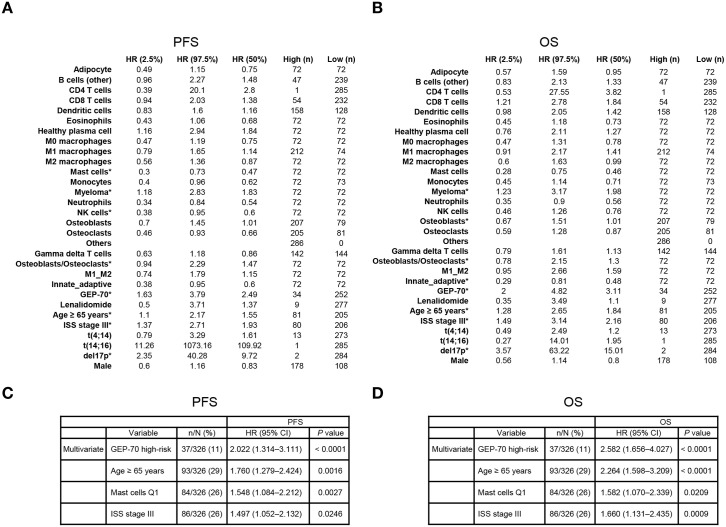
Pretreatment regression models for cell-type, clinical, and cytogenetic characteristics.(A, B) Univariate Cox proportional HRs for PFS and OS (respectively) from 286 pretreatment samples with full cytogenetics and tumor burden data. Those cell types, ratios, and cytogenetic and clinical characteristics marked with an asterisk remain after multivariate Cox proportional hazard lasso regression, implying that they contain independent information about patient outcomes. Myeloma refers to the pathologist estimates of tumor cell percentages (rather than the deconvolution estimates). Lenalidomide indicates those 9 patients who received lenalidomide during treatment, testing whether this was skewing the results. (C, D) Variables added during stepwise Cox regressing using variable quartiles as predictors. CD, cluster of differentiation; CI, confidence interval; del, deletion; GEP-70, 70-gene Prognostic Risk Score; HR, hazard ratio; ISS, International Staging System; NK, natural killer; OS, overall survival; PFS, progression-free survival; Q, quartile; t, translocation.